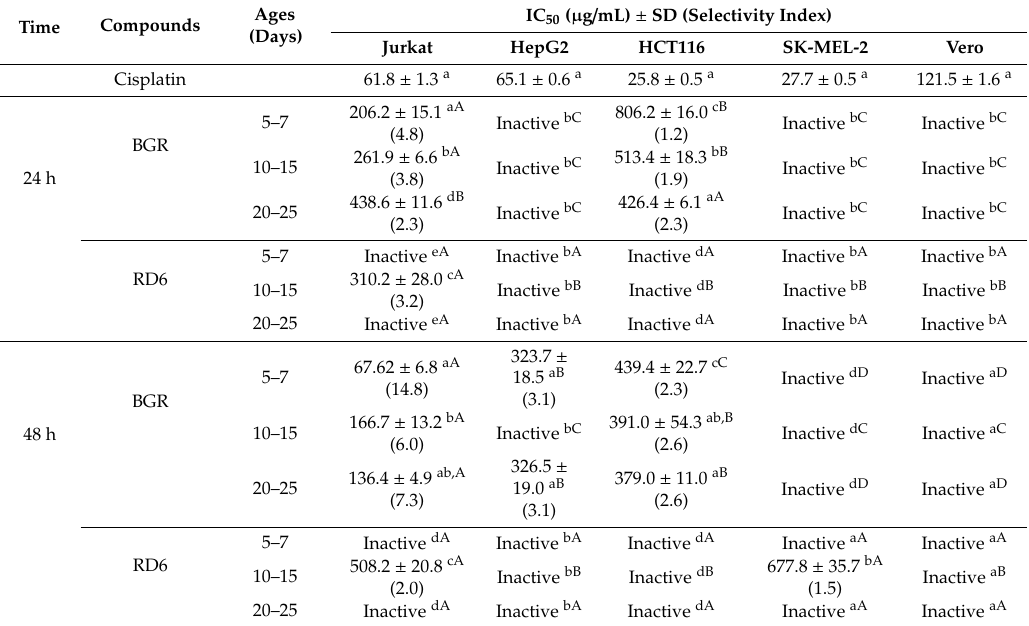
Table 4. The e ff ect of rice sprout extracts on cell viability of various cancerous (Jurkat, HepG2, HCT116, and SK-MEL-2) cell lines and noncancerous (Vero) cell line at 24 and 48 h. Data expressed as mean ± SD of half-maximal inhibitory concentration (IC 50 ) from five